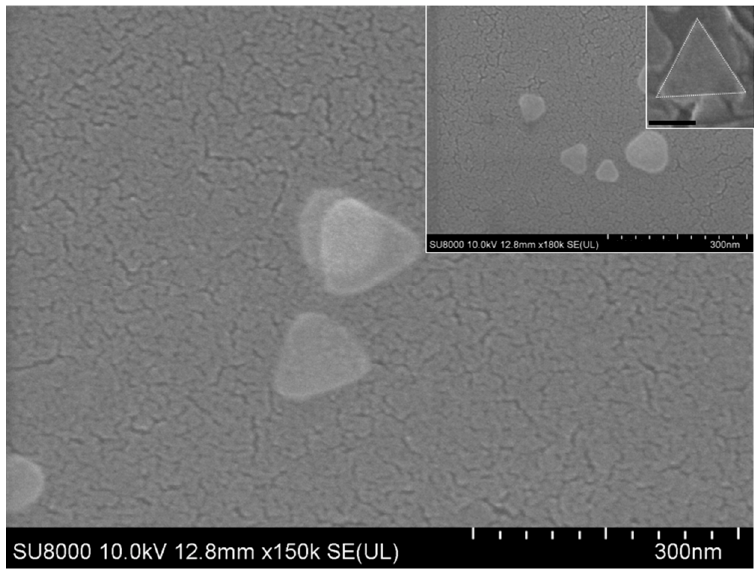
Figure 2. SEM pattern of the as-prepared silver nanoprism Ag-NPrs (the inset scale bar 300 nm).